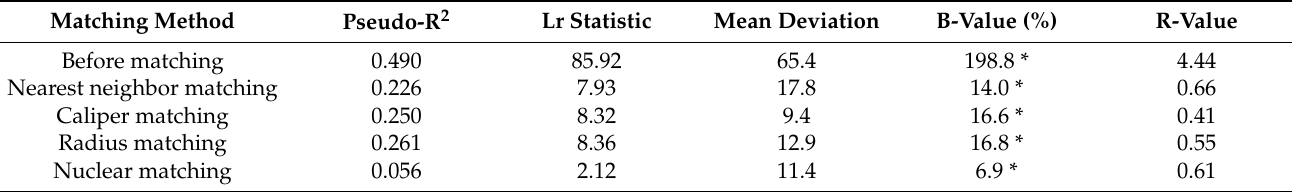
Table 7. The matching balance assumption test